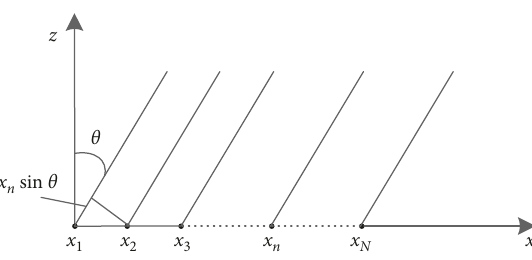
Figure 1: Diagram of a linear sparse array with N